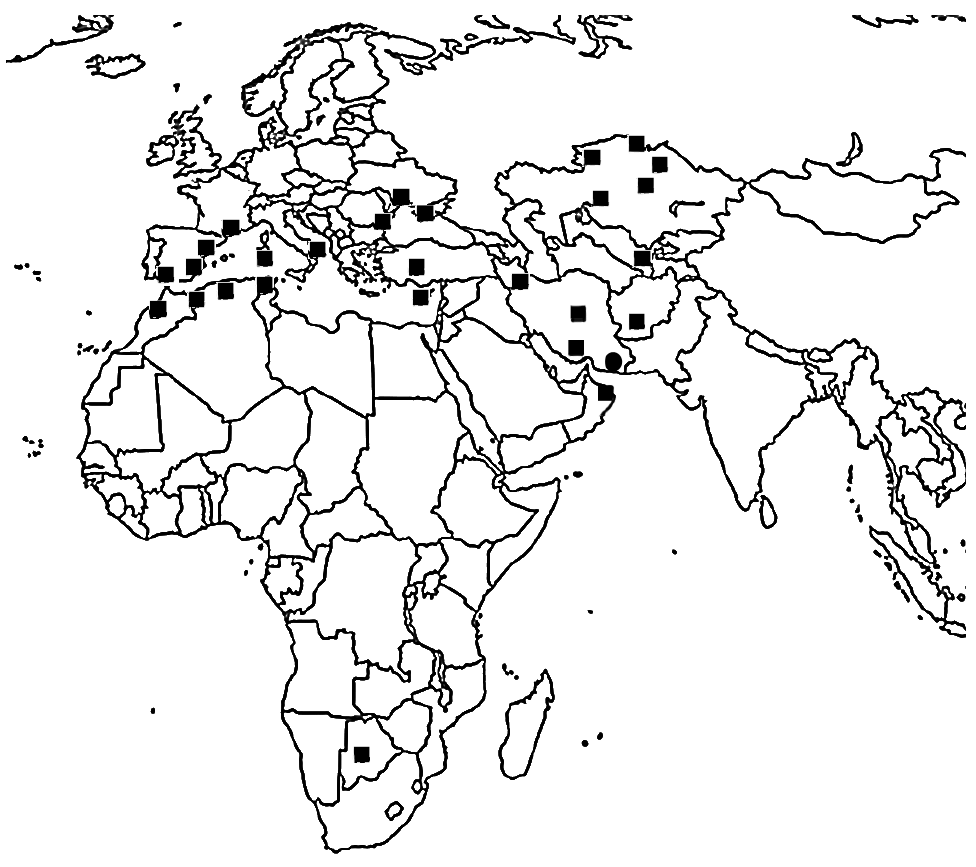
F IGURE 2. World distribution of Phallocryptus spinosa. (cid:132) previous world records, (cid:122) locality in current study A